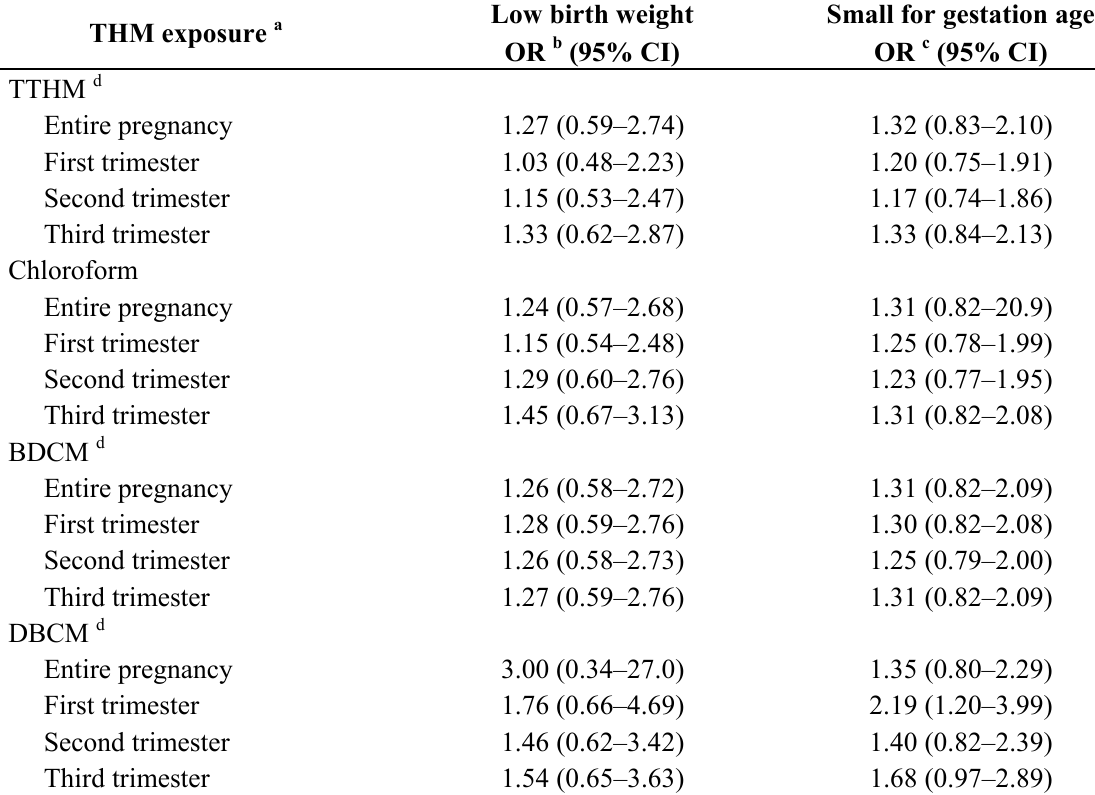
Table 2. Low birth weight and small for gestation age adjusted odds (OR) ratios and 95% confidence intervals (CI) for trimester-specific and entire pregnancy exposure to internal dose